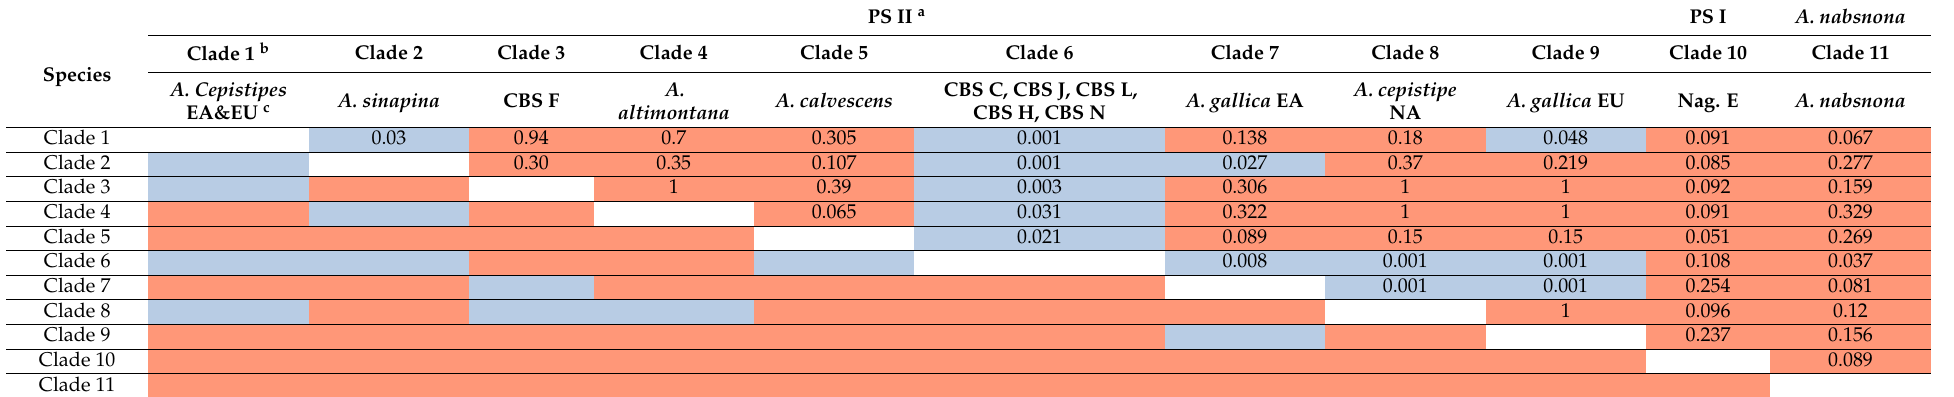
Table 2. PHI test (above diagonal) and compatible test (below diagonal) of phylogenetic clades within the Gallica